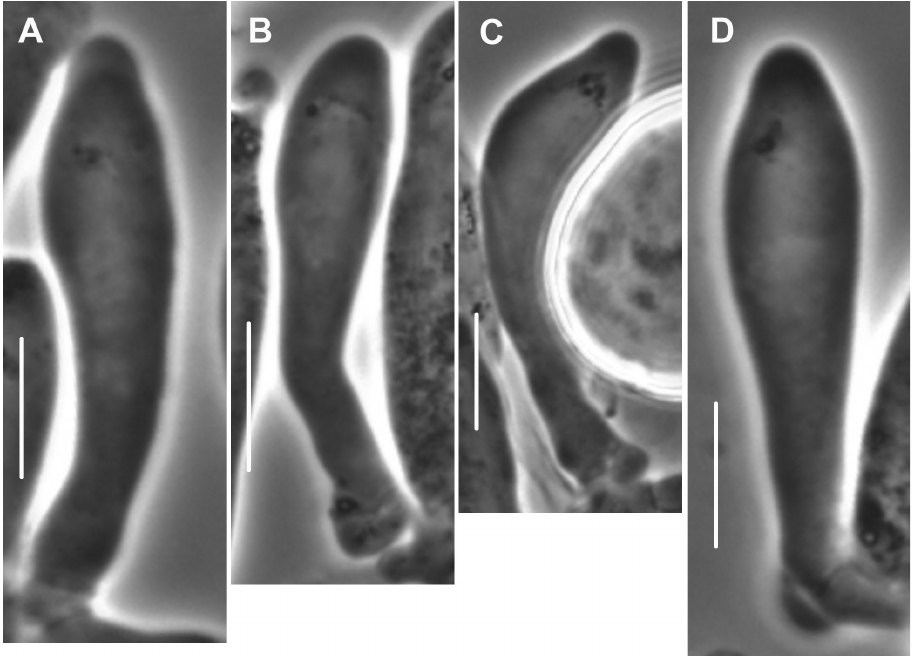
Figure 44. Mycetinis olidus . Pleurocystidial structures. Standard bars = 10 µm. VA 97 257 (TENN